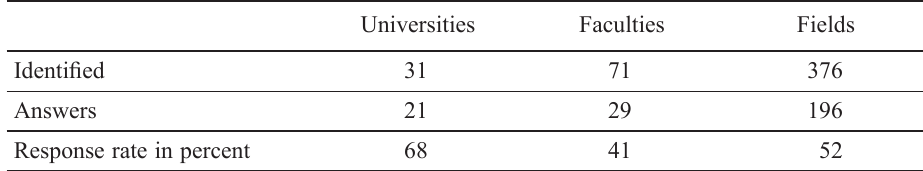
Table 2. Response rate for survey,